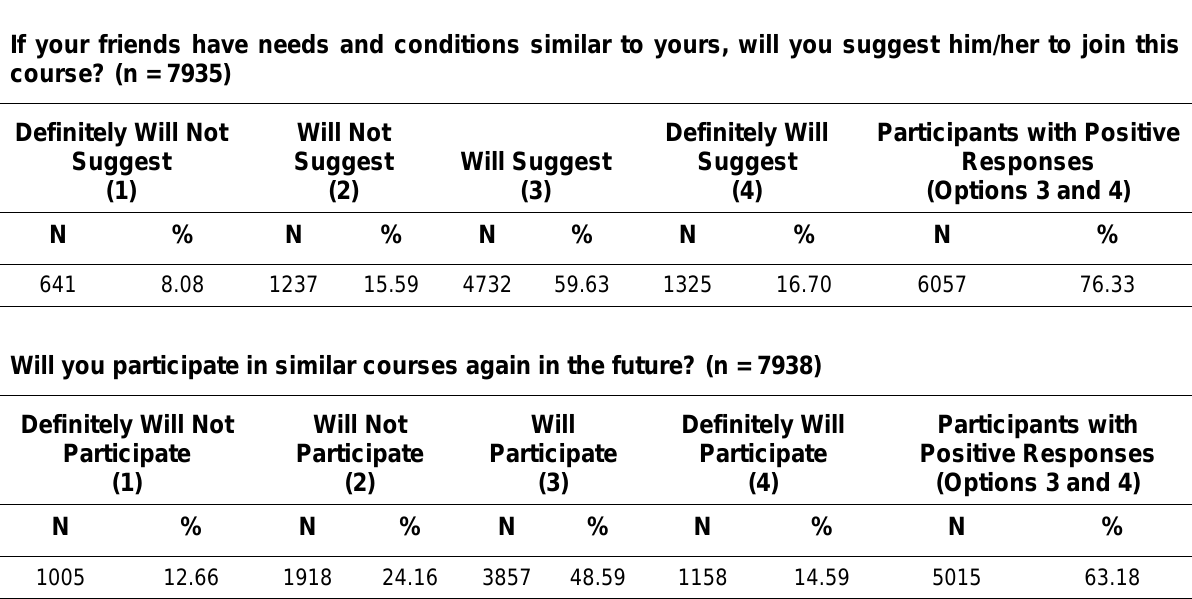
Other Aspects of Subjective Outcome